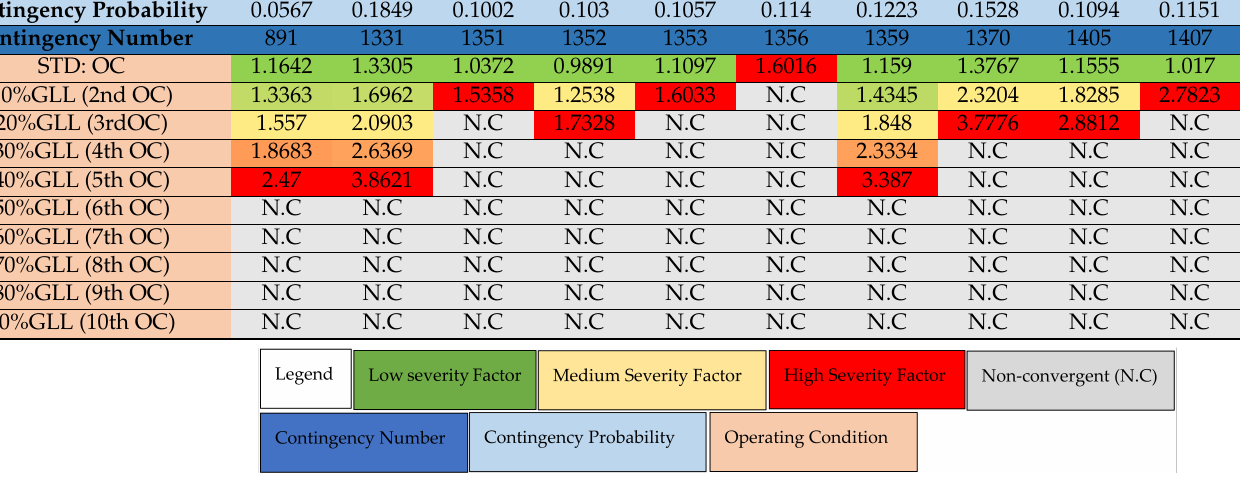
Table 4. Severity factor behavior of operational risk of undervoltage for varying operating